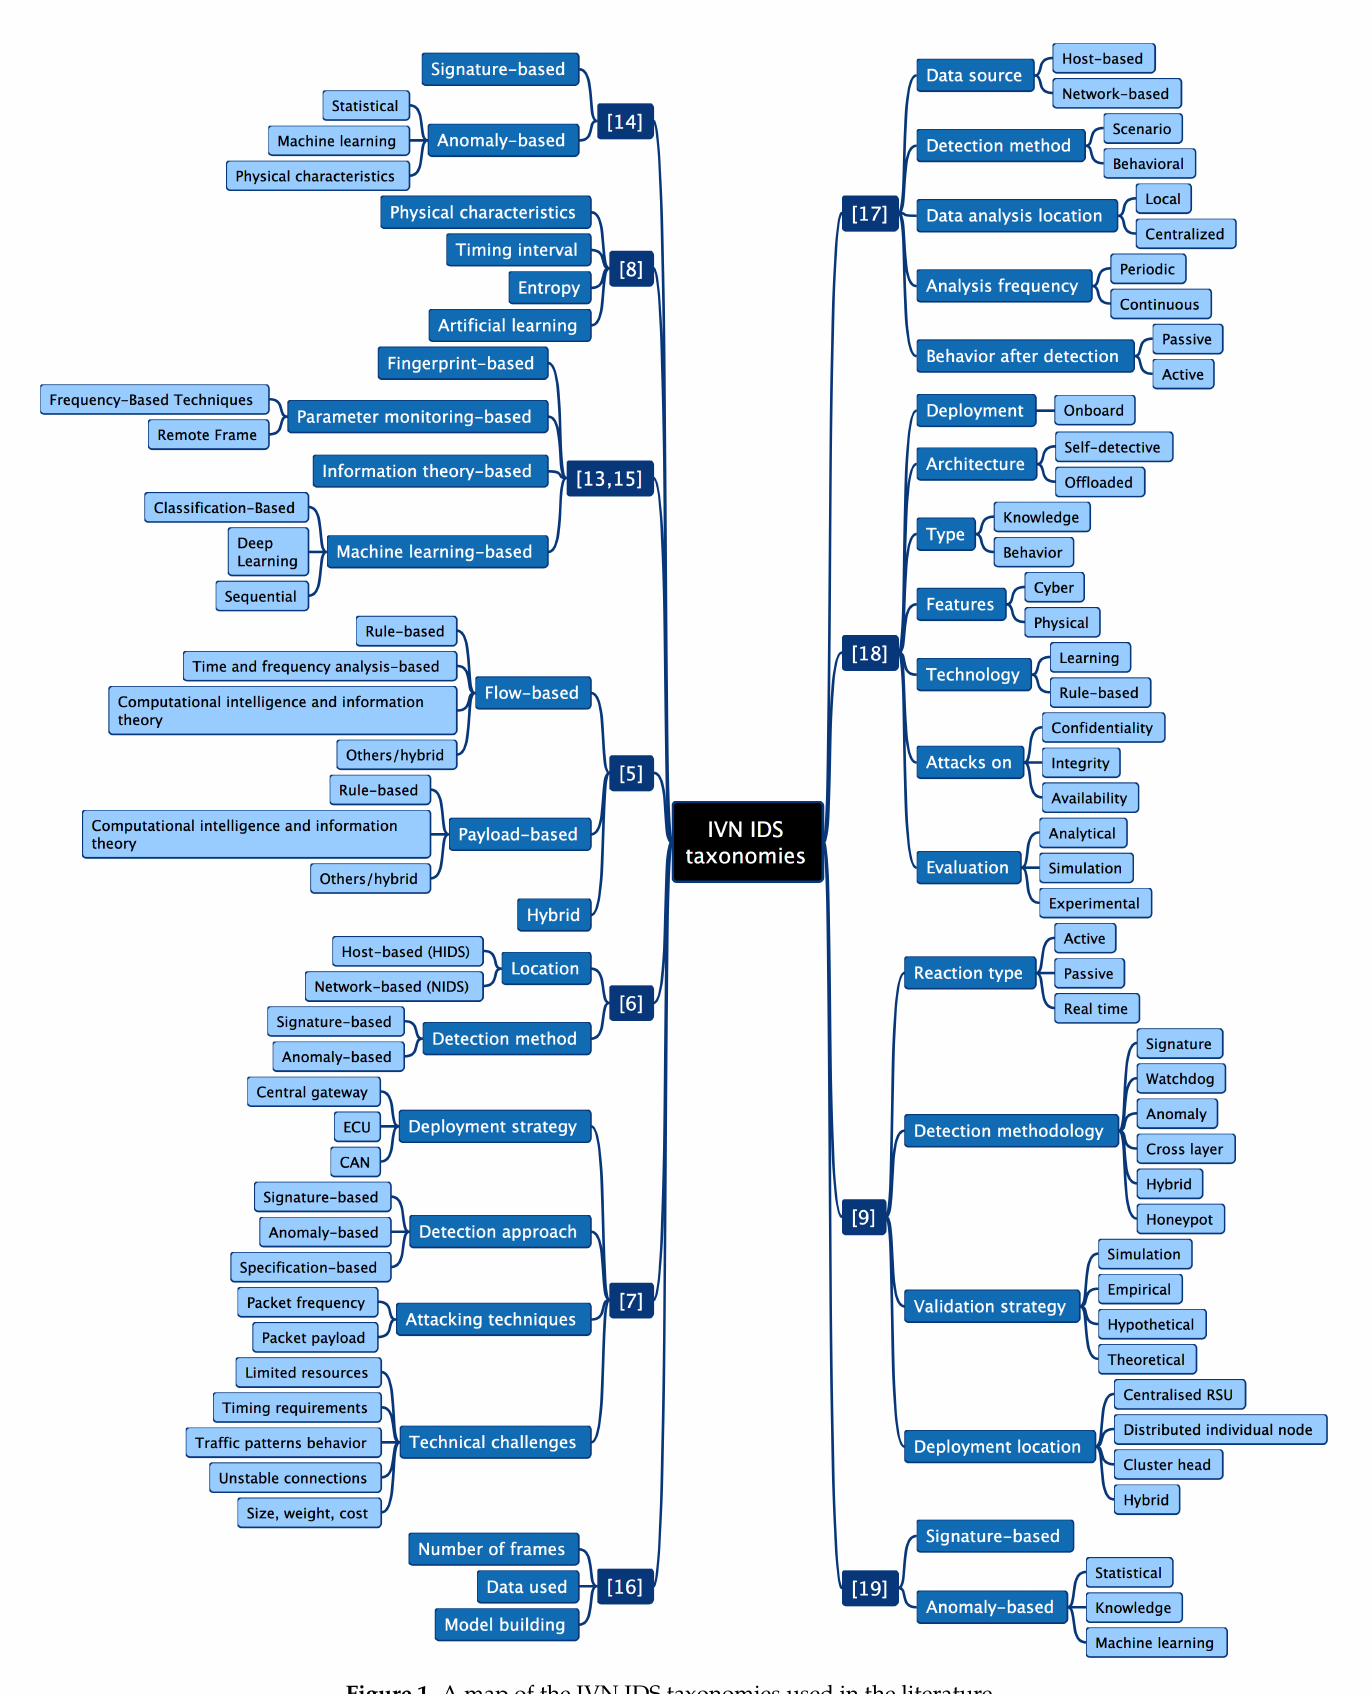
Figure 1. A map of the IVN IDS taxonomies used in the